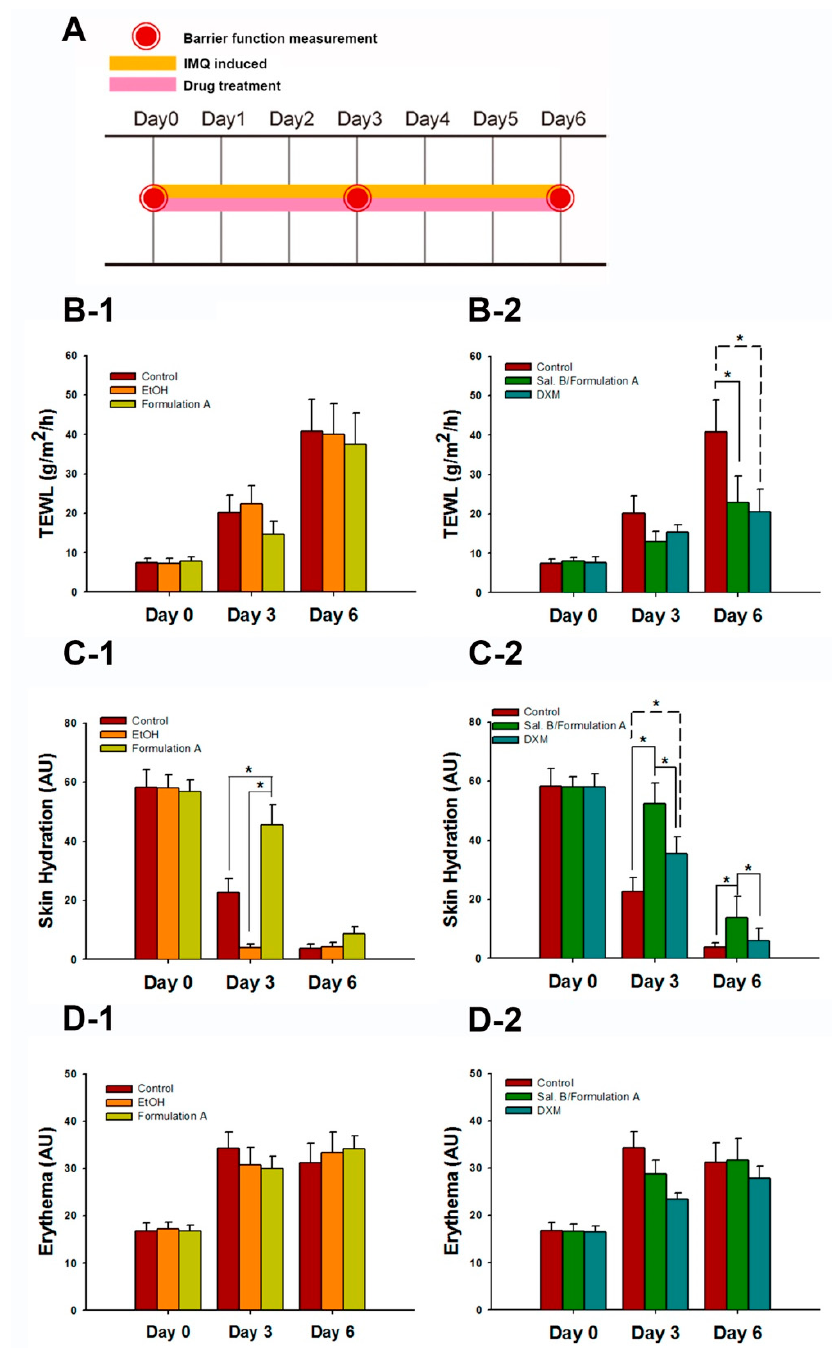
Figure 4. Sal. B/formulation A and desoximetasone ointment (DXM) restored the barrier function. ( A ) The study design. After three to four hours of IMQ application, mice received 100 μ L Sal. B in Formulation A, Formulation A, or 60 mg DXM on the dorsal skin once daily. Barrier functions were measured on the dorsal skin before the application of drugs on day 0, day 3, and day 6. ( B-1 ) Transepidermal water loss (TEWL), ( C-1 ) skin hydration, and ( D-1 ) DXM represented the change of barrier function for the in vivo topical carrier selection study. ( B-2 ) TEWL, ( C-2 ) skin hydration, and ( D-2 ) erythema represented the change in barrier function for the anti-psoriasis treatment study. (mean ± SD, n = 4); * p < 0.05; one-way ANOVA (Scheffe). 3.4. Sal. B / Formulation A and 0.25% DXM Restored Barrier Function Sal. B/formulation A (22.85 ± 6.69 g/m 2 /h) and DXM (20.49 ± 5.69 g/m 2 /h) treatment significantly restored the TEWL values compared to those of the control group (40.79 ± 8.05 g/m 2 /h) on day 6